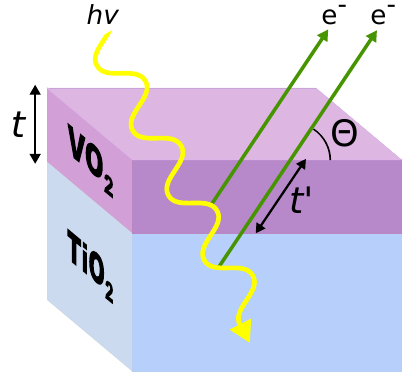
Figure 1. A schematic representation of our VO TiO (100) substrates. The photoelectrons, once generated, must travel through some length of the 2 material before they escape the surface and can be detected.